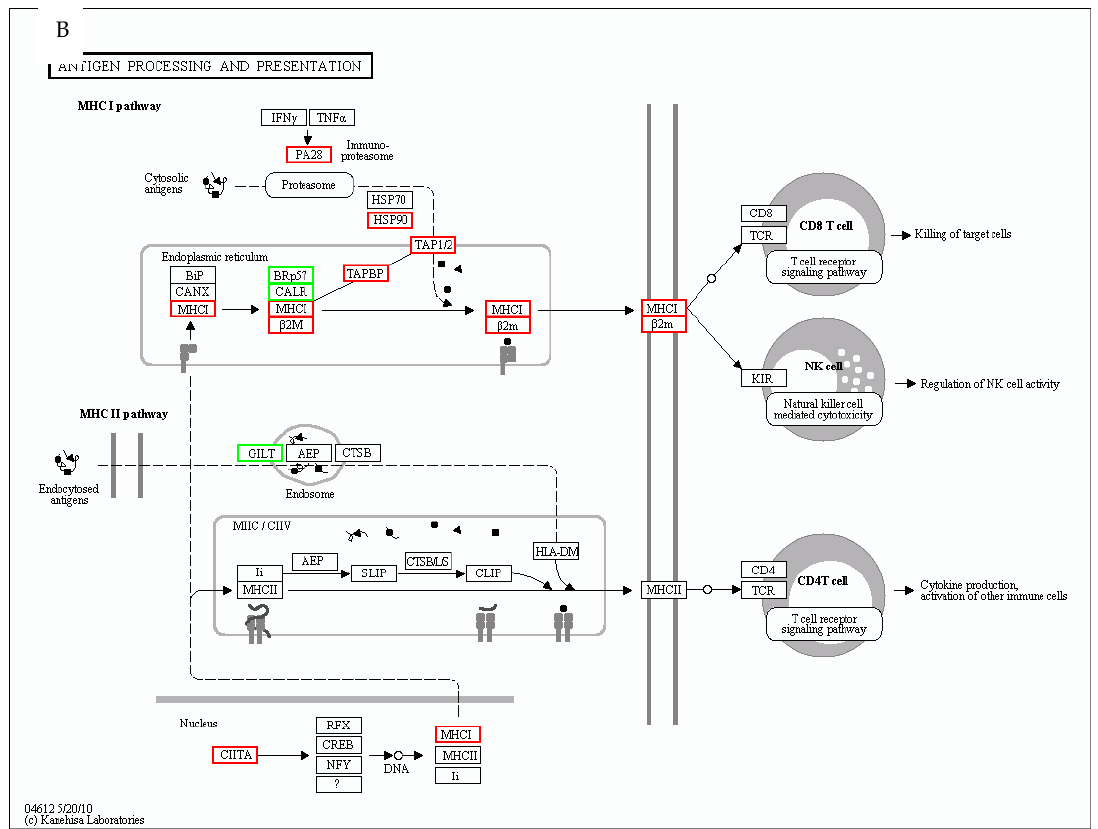
Figure 2. Shows antigen processing and processing pathways for the TO-vs.-SAV3/IFN and TO-vs.-SAV3 generated by the KEGG pathway software analysis. ( A ) Network pathway for TO-vs.-SAV3. ( B ) Network pathway of TO-vs.-SAV3/IFN antigen processing and presentation in TO-cells. Red squares depict upregulated genes, while green squares depict downregulated genes in the pathway. Dots, triangles and squares show broken down antigens as cytosolic antigens in MHC-I and endocytosed antigens in MHC-II pathways. Solid lines show activation and dotted lines show alternative pathways. The mixed shading of red/green squares represents a mixed population of upregulated and downregulated genes. Note that there were more downregulated genes in the type I IFN-treated cells (TO-vs.-SAV3/IFN) (Figure 2A) than in the non-treated cells (TO-vs.-SAV3) (Figure 2B).